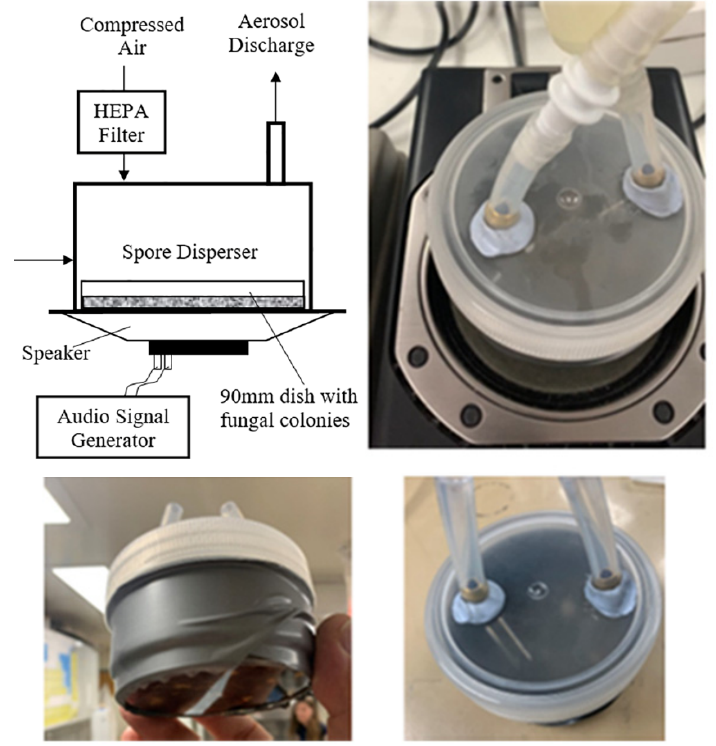
Figure 4. Fungal particle generator.